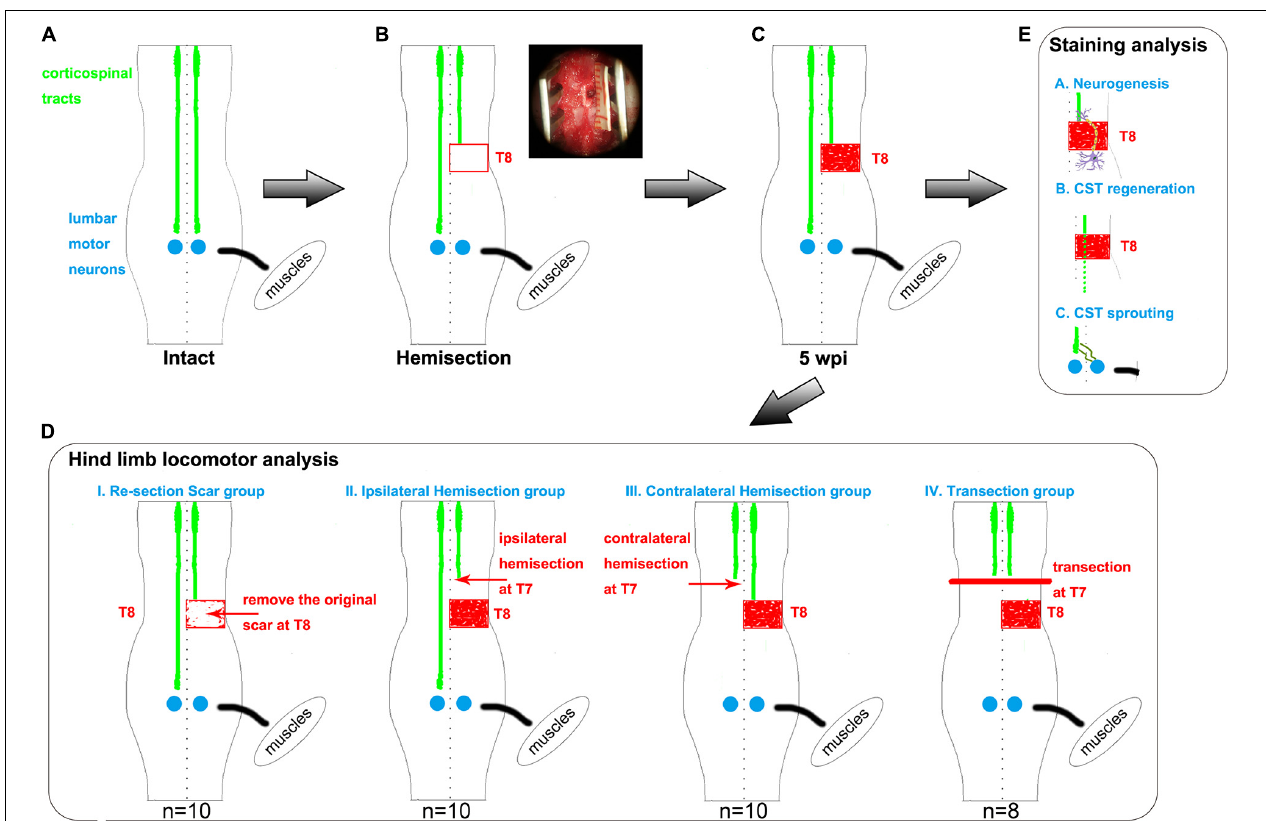
FIGURE 1 | Hemisection model and different second operations for each group. (A–C) The establishment of hemisection model rats. (A) represents intact rats. (B) represents hemisection model rats that underwent a right hemisection at the T8 level. The red rectangle symbolizes the hemisection injury with a width of 2 mm. In the upper right corner, the surgery photo is taken under a microscope, visually displaying a full unilateral (right) hemisection operation. The red-filled rectangle in panel (C) indicates the scar observed five weeks post the hemisection injury. (D) Five weeks after the first hemisection operation at the T8 level, four different second operations are further established based on hemisection model rats. The red arrows indicate the second hemisection operation. The thick red line indicates a transection. The Re-section Scar group ( n = 10) underwent a second hemisection operation at the original injury site to remove the scar. The Ipsilateral Hemisection group ( n = 10) underwent a second hemisection operation on the ipsilateral side at T7. The Contralateral Hemisection group ( n = 10) underwent a second hemisection operation on the contralateral side at T7. The Transection group ( n = 8) underwent a transection operation at T7. (E) represents the possible mechanisms of the spontaneous locomotor recovery in hemisection model rats, including neurogenesis, CST axon regeneration, and CST axon sprouting. CST indicates the corticospinal tract.